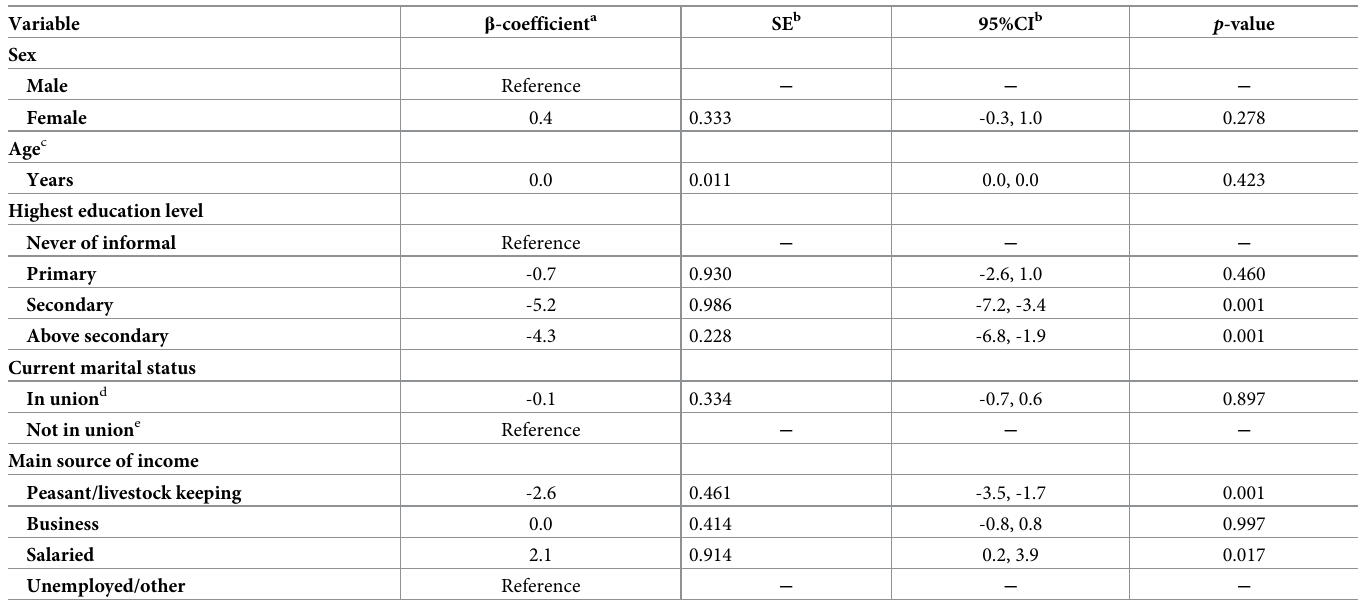
Table 4. Association between individual-level factors and attitudes towards TB